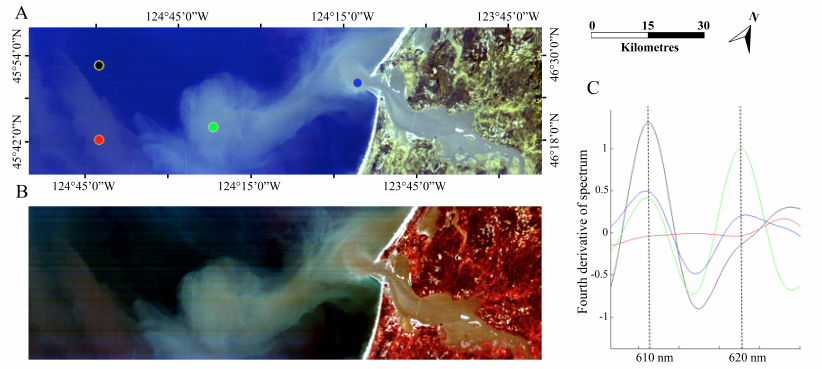
Figure 5. Image of the Columbia River meeting the Pacific (northwest USA) from HICO on 12 May 2012 at 1:05 GMT. ( A ) RGB image; ( B ) The plume structure is highlighted with the enhanced image; ( C ) Channels sensitive to plume sediments are selected using derivative analysis. Figure courtesy of N. B. Tufillaro [260]. Approximate scale, north arrow and